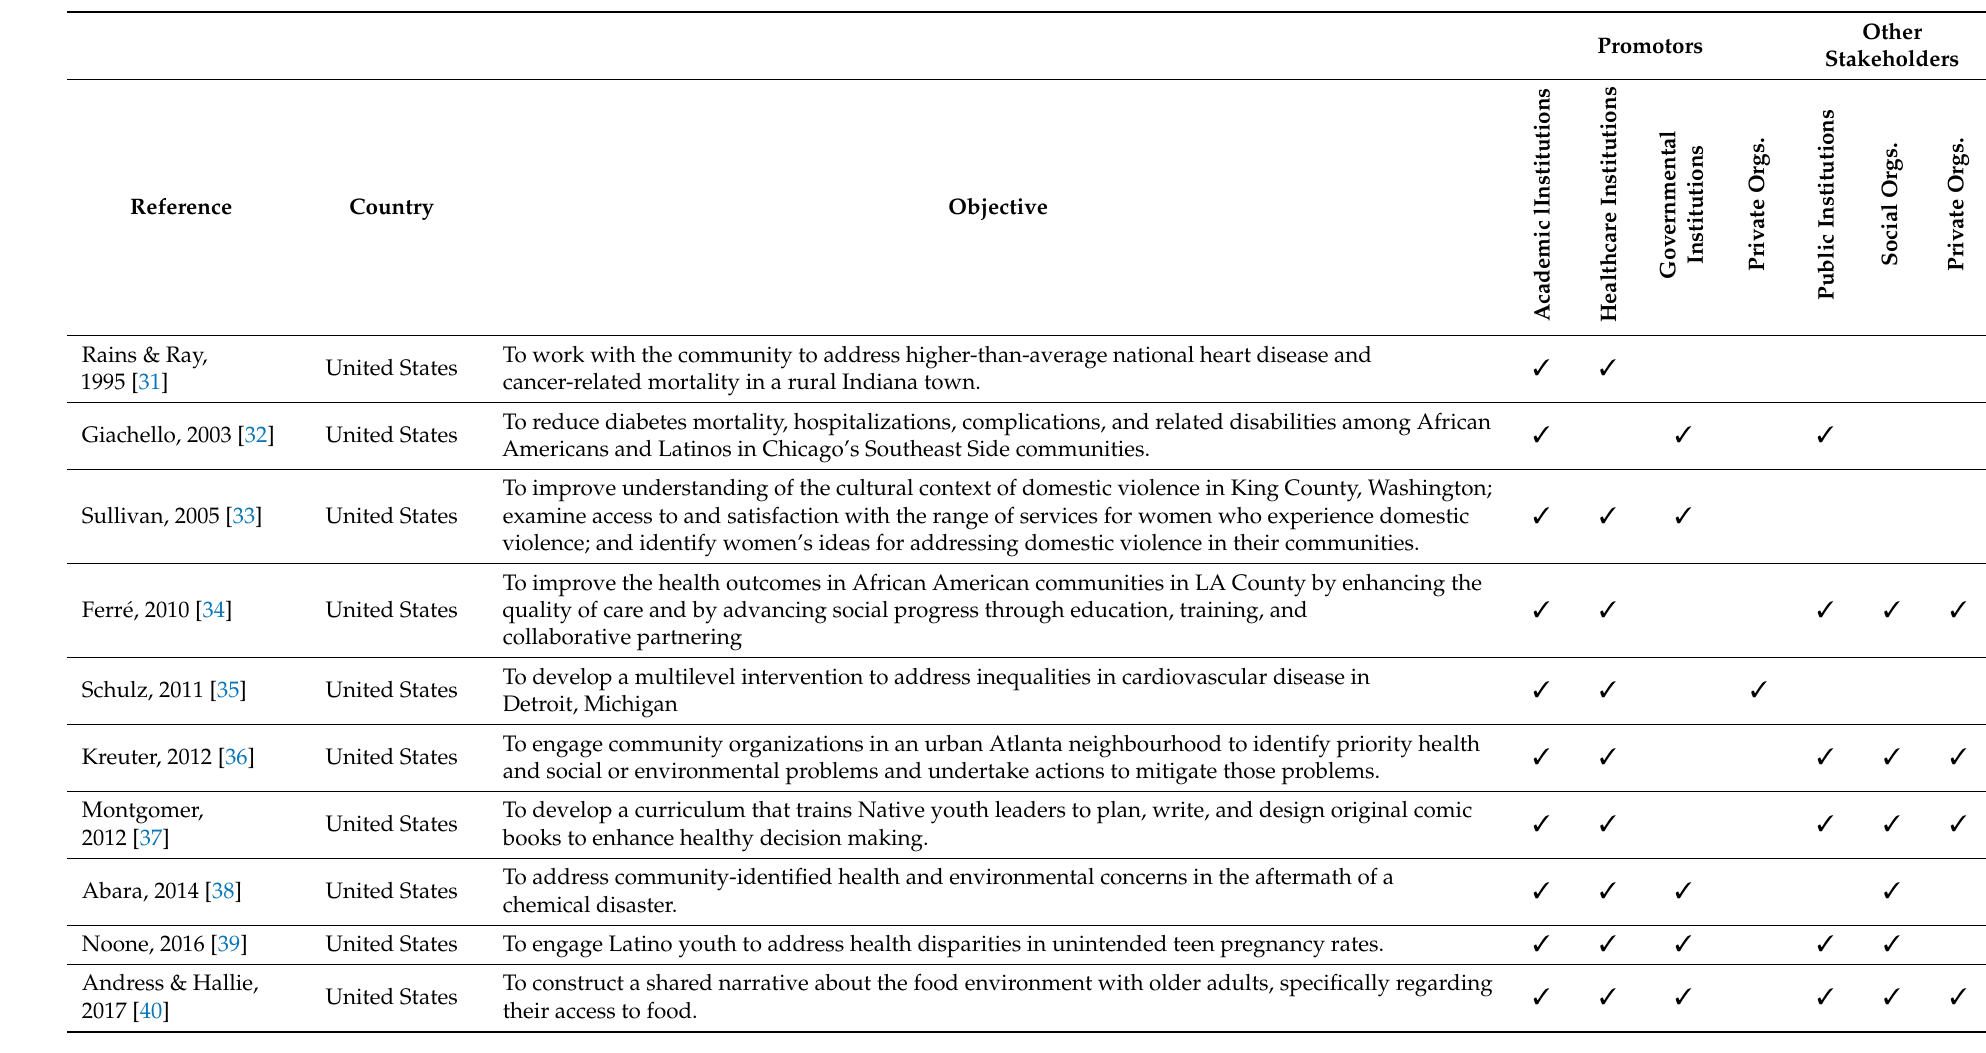
Table 1. Country, objective, promotors, and other stakeholders involved in the 31 co-created public health actions based on equity reviewed.